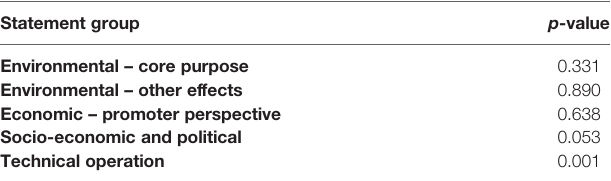
TABLE 3 | p -value of the Mann-Whitney U tests.